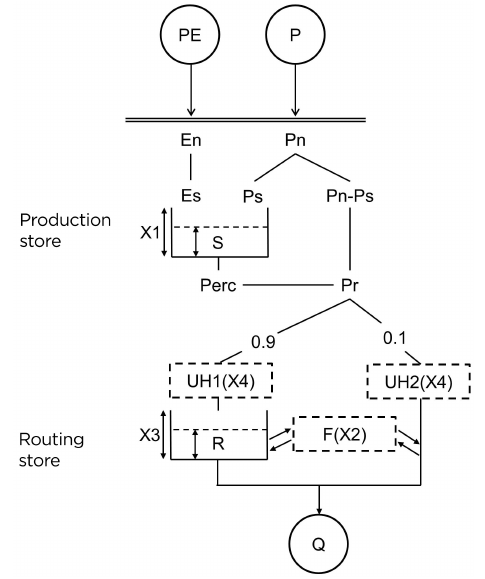
Figure 2. The schematised structure of GR4J (X1–X4: model pa- rameters; PE: potential evapotranspiration; P : precipitation; Q : runoff; other letters indicate variables conceptualising internal catchment